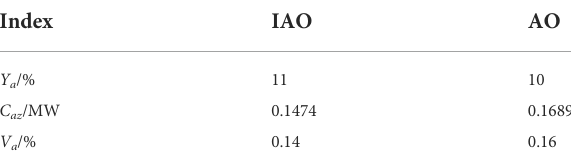
TABLE 1 Result comparison between IAO-SDT algorithm and AO-SDT